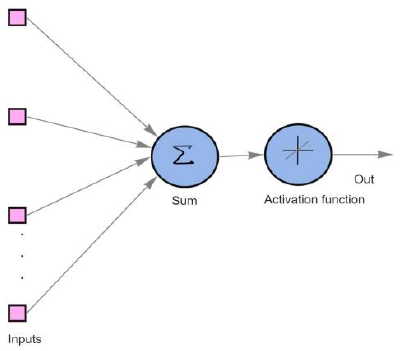
Figure 7. Adaptive Linear Element (ADALINE) model.